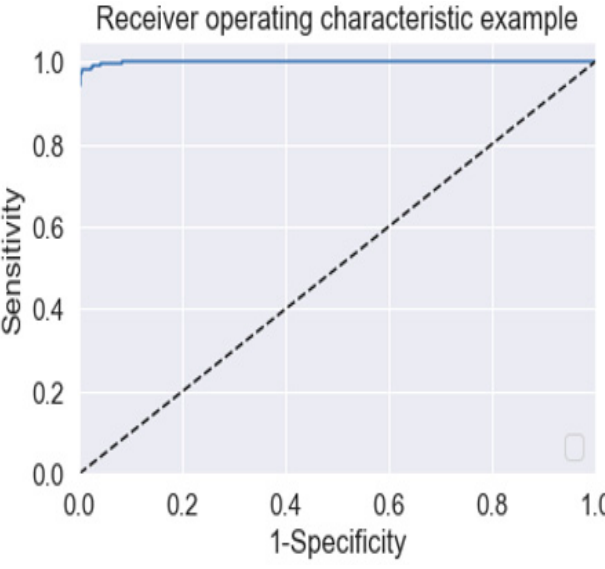
Figure 9. Plotted ROC Curve for model trained in this work.